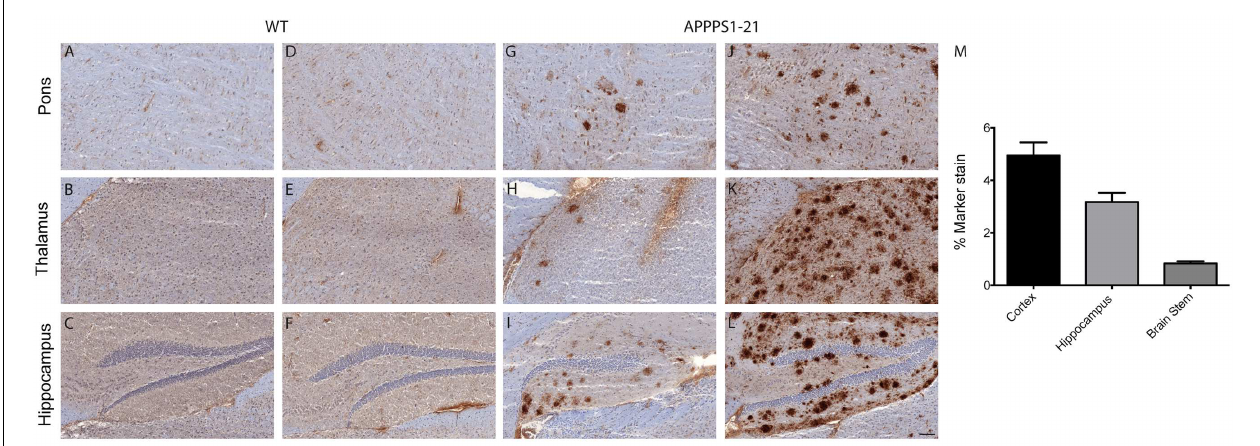
FIGURE 3 | Immunohistochemistry demonstrates that [ 89 Zr]-Df-Bz-JRF/A β N/25 labels plaques to a low extent after i.v injection. Sagittal brain slices (20 µ m) were cut and the sections were stained for amyloid- β . Images (A–C,G–I) represent in vivo labeling arising from i.v injections of [ 89 Zr]-Df-Bz-JRF/A β N/25 and are compared to adjacent slices that were stained for total plaque load (D–F,J–L) . (Scale bar = 100 µ m). Graph (M) depicts quantification of amyloid- β staining in the cortex, hippocampus and brain stem. Data is shown as the mean + SD.